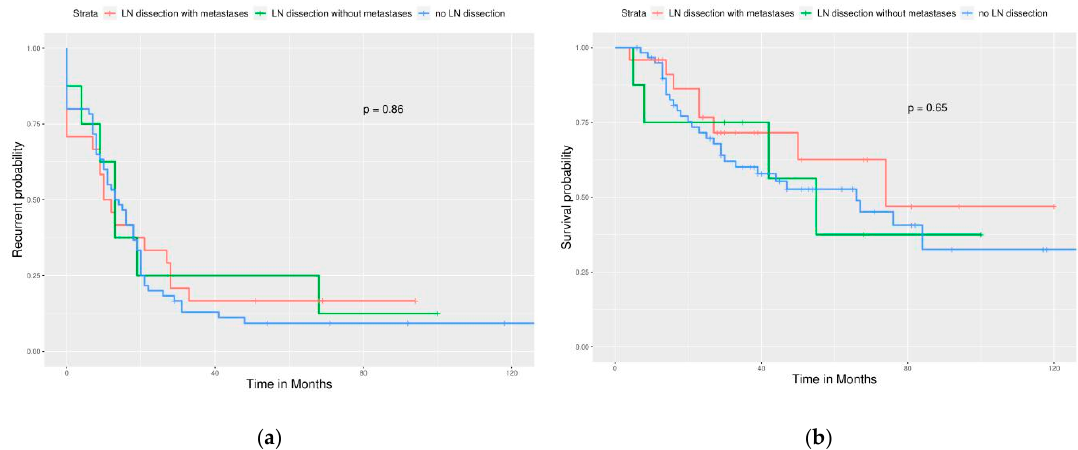
Figure 10. Survival curves of PFS and OS by LN status (Sub-optimally debulked group). ( a ) PFS, p = 0.86. ( b ) OS, p = 0.65. This means that LN dissection could be omitted if optimal debulking cannot be achieved.